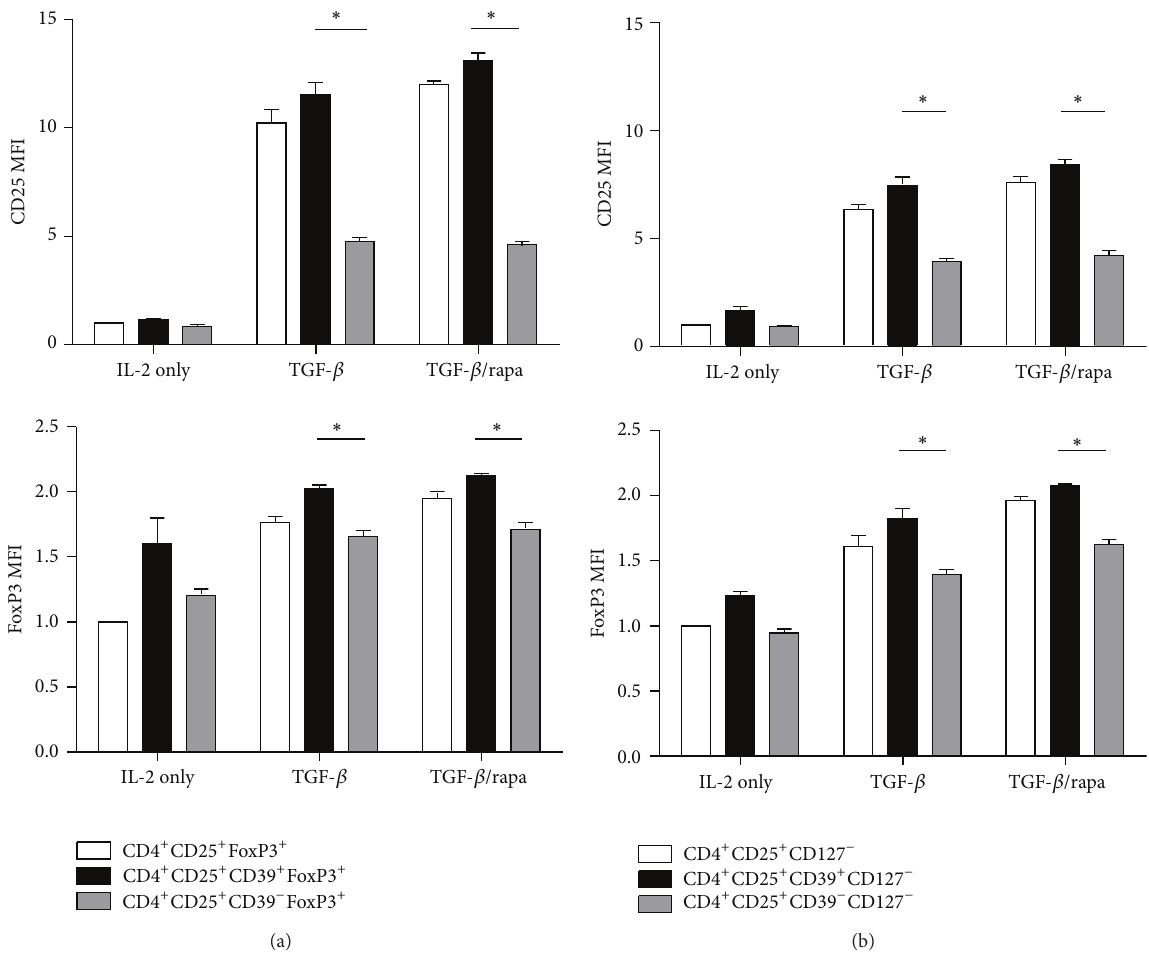
Figure 5: Rapamycin induced CD39 + iTreg cells showed a greater CD25 and FoxP3 expression. Relative CD25 and FoxP3 MFI of CD25 + CD39 + FoxP3 + and CD25 + CD39 − FoxP3 + in (a) CD4 + CD25 + FoxP3 + iTreg cells and (b) CD4 + CD25 + CD127 − iTreg cells. The values indicated the mean ± SEM of 3 separate experiments. ∗ 𝑃 < 0.05